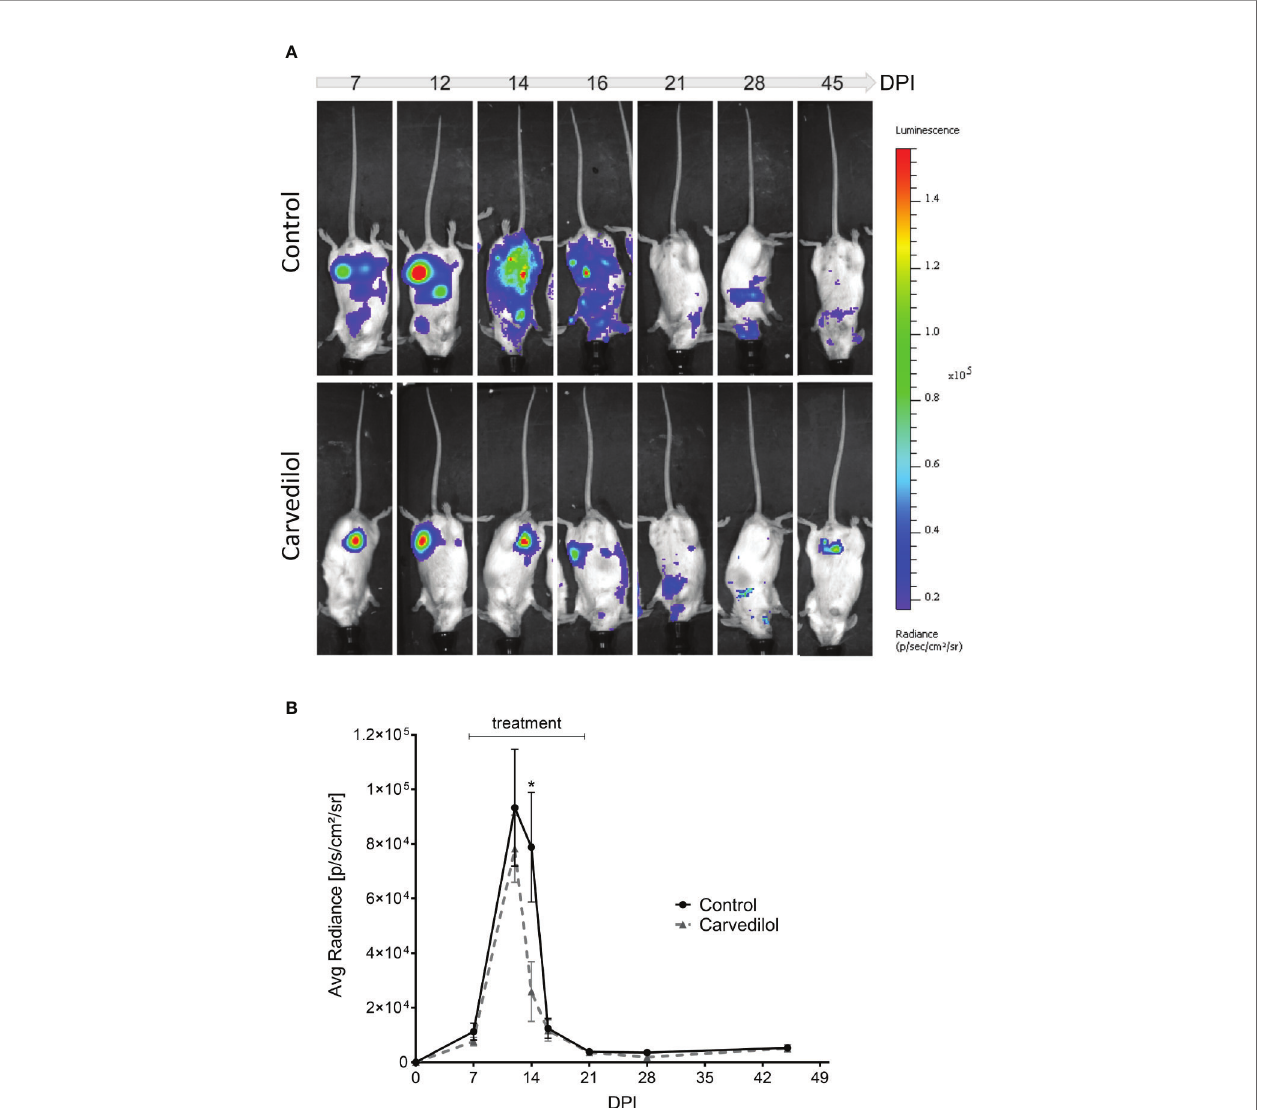
FIGURE 7 | Live imaging of bioluminescent parasites shows action of carvedilol in vivo. 2 groups of 5 mice were infected with 5000 trypomastigotes Tulahuen strain with the Luc-mNeonGreen incorporated. At 7 DPI, 2 animals from each group were treated with carvedilol 25 mg/kg/day for a period of 14 days and periodically measure their body luminescence (see materials and methods). (A) Images show the level of parasitism detected by the live imaging luminescence representative of the 2 groups at different days after infection. Right panel indicates the luminescence scale. (B) The scatter curve graph shows the means ± SD of radiance measurements obtained in each group at the different days after infection. One-way ANOVA statistical analysis was performed with Tukey multiple comparison test. Signi fi cance levels established by p-values * ≤